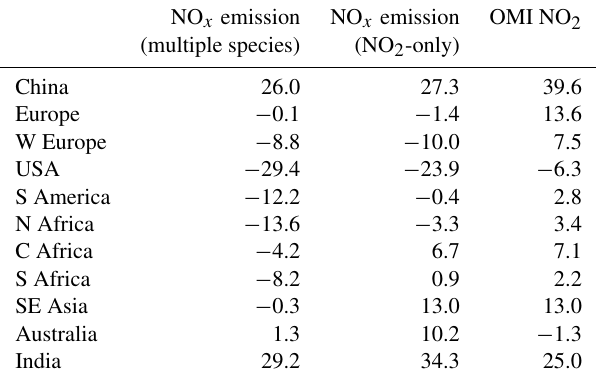
Table 4. Linear trend (in % per decade) of the regional a posteriori NO x emissions from the multiple-species assimilation (left column) and NO 2 -only assimilation (central column), and of the regional mean tropospheric NO 2 columns from OMI (right column) for the period